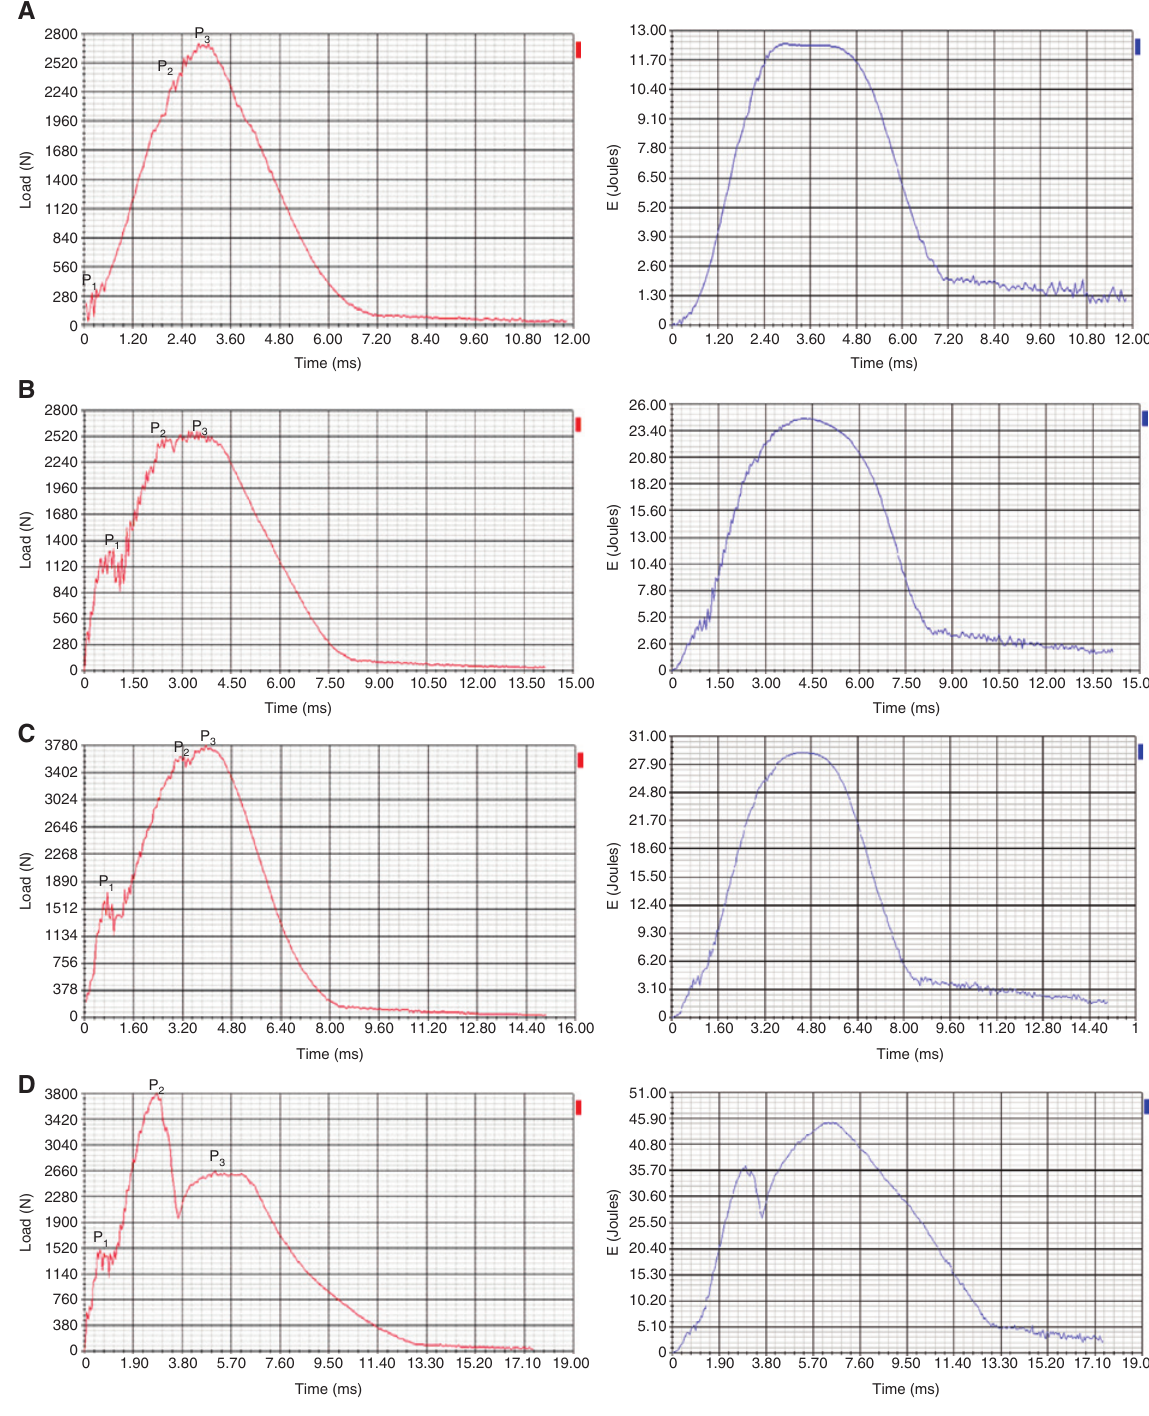
Figure 5 Load-time and energy-time plot for C16 panel at different impact energy levels. (A) Impact energy -12.64 J, (B) impact energy -25.27 J, (C) impact energy -37.64 J (D) impact energy -50.19 J. mixture of LY556 epoxy resin and HY 951 hardener mixed in a ratio of 10:1. The epoxy resin mixed with hardener has a density of 1.19 g/cm 3 , tensile strength of 52 MPa and shear modulus of 1230 MPa. The ply was stacked in 0 ° /90 ° orientation and was built to a thickness of